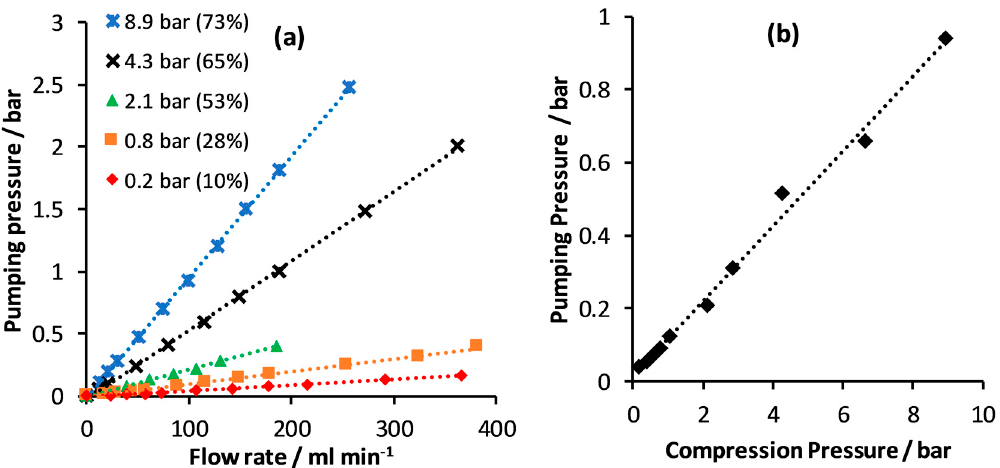
Figure 2. ( a ) Plot of pumping pressure vs. flow rate for water at ambient temperature through samples of GFD 4.6EA at different compression pressures (% compression given in brackets). ( b ) Plot of pumping pressure for a 100 mL min − 1 flow rate of water at ambient temperature through GFD 4.6EA at different compression pressures.